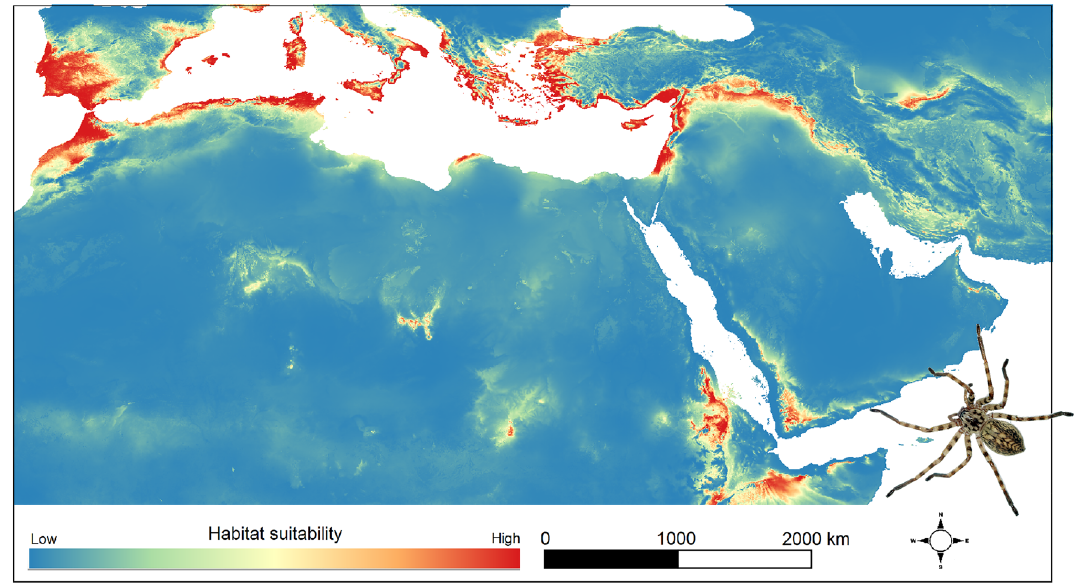
Figure 2. Distribution model of the walckenaeri clade. The distribution model was created using Maxent software 3.4.1 (http:// biodi versi tyinf ormat ics. amnh. org/ open_ source/ maxent/) and mapped in QGIS 3.22.3 (https:// www. qgis. org). The spider was photographed by Majid Moradmand.